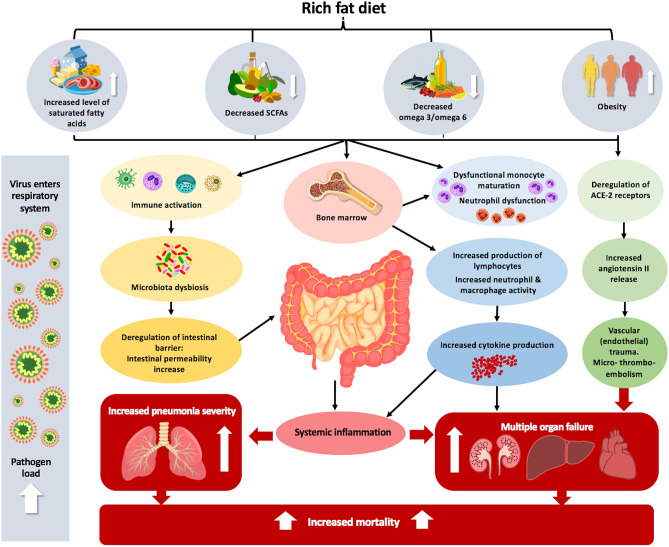
The effect of inadequate fat intake and obesity on the pathophysiology of COVID-19. Increased dietary level consumption of saturated fatty acids, decreased level of SCFAs and omega 3/omega 6 combined with obesity can lead to immune activation. This immune activation can alter microbial composition in the intestine, leading to dysbiosis, which consequently enhances systemic inflammation. The complexity of the intestinal microbiota is correlated with dysfunctional monocyte maturation and neutrophil dysfunction in the bone marrow. Obesity also leads to deregulation of ACE2 receptors in the lungs, which predisposes and makes entrance the virus easier and leads to increased angiotensin II release, which causes vascular (endothelial) trauma and micro-thrombo-embolism in various organs, leading to multiple organ failure. Altogether, these different factors that lead to the body being unbalanced can increase pneumonia severity and mortality, which is more acute in the case of lung viral infection.